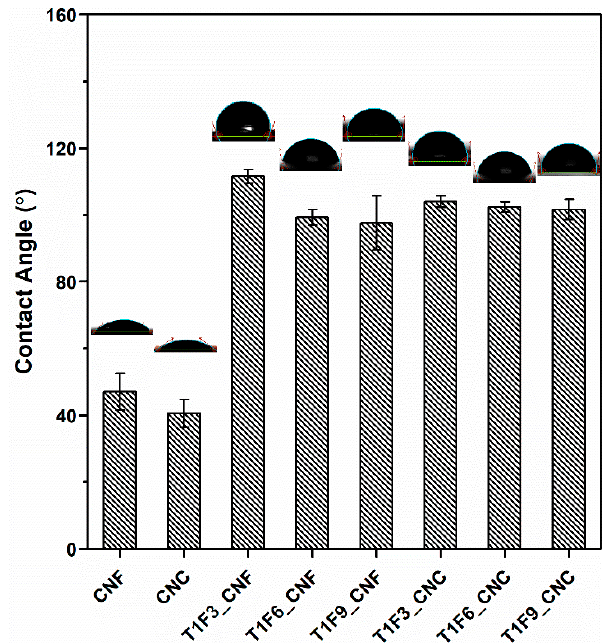
Figure 4. Contact angle plots and water droplet images for CNF, CNC, CNF-reinforced (T1F3_CNF, T1F6_CNF, and T1F9_CNF), and CNC-reinforced biocomposite films (T1F3_CNC, T1F6_CNC, and T1F9_CNC).